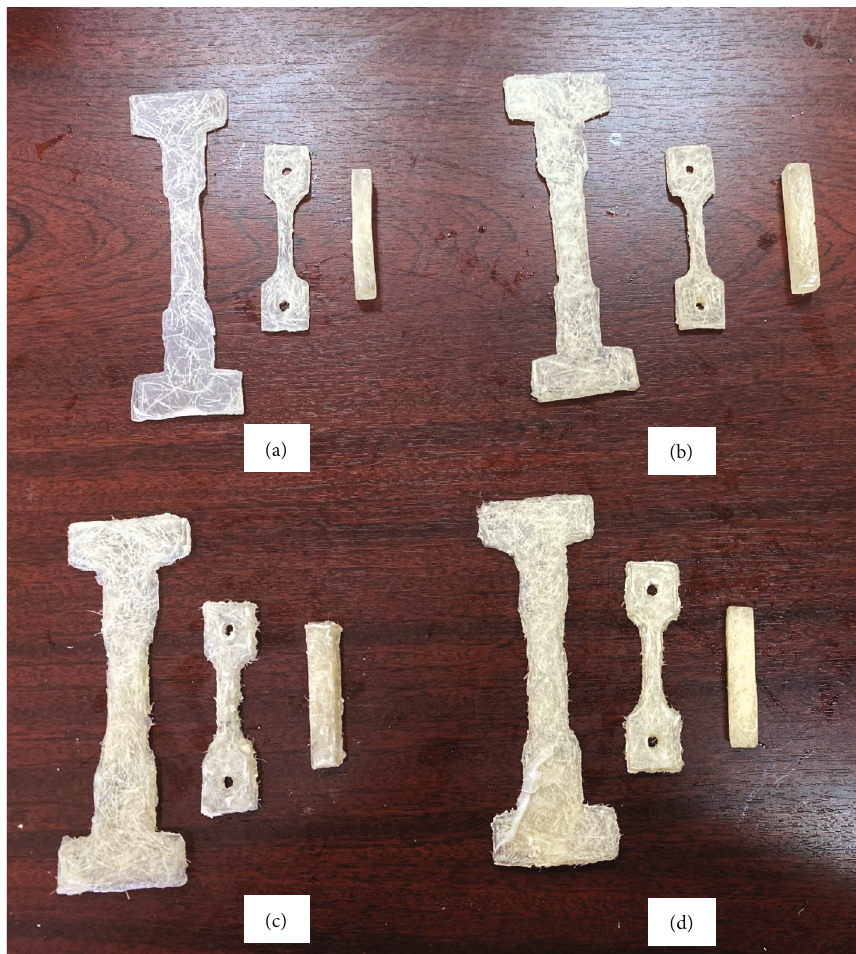
Figure 4: Di ff erent types of specimens with di ff erent ratios of DPF in Epoxy – DPF composites: (a) 5wt%, (b) 10 wt%, (c) 15wt%, and (d) 20wt%.